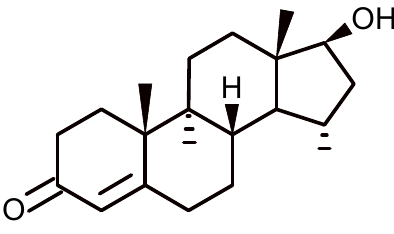
Figure 8. Chemical structure of testosterone.